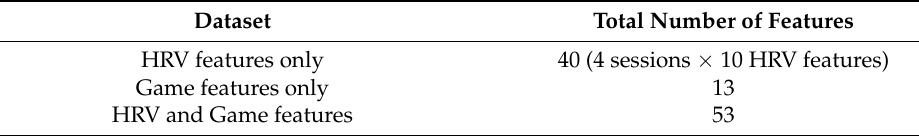
Table 1. Sizes for each dataset.